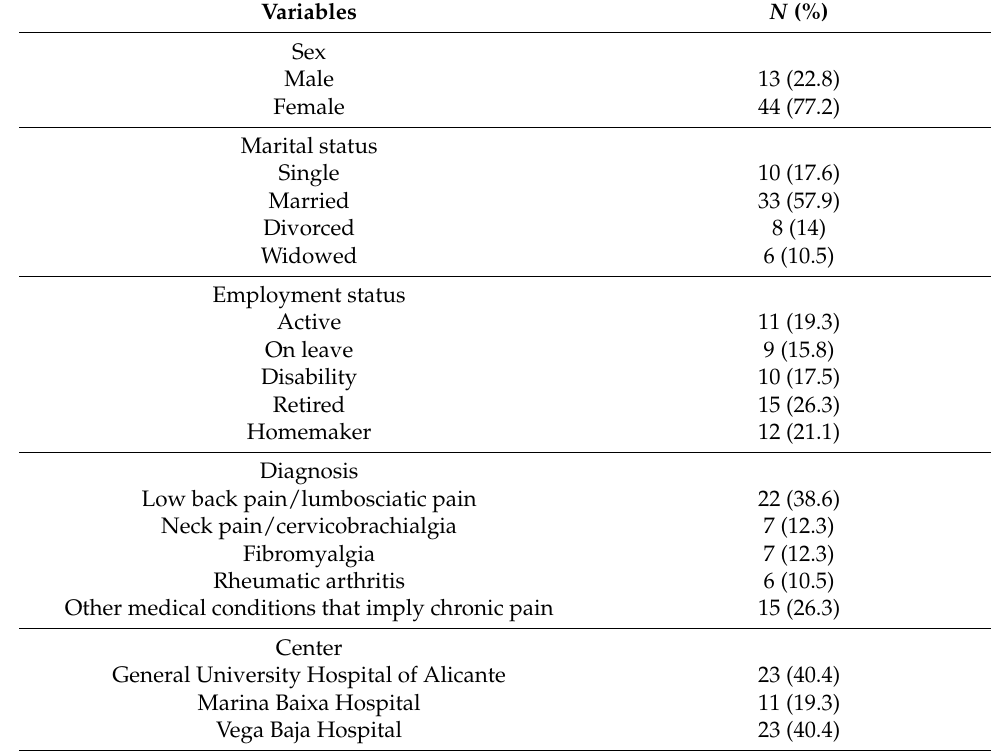
Table 2. Sociodemographic characteristic and medical diagnoses of the participants.